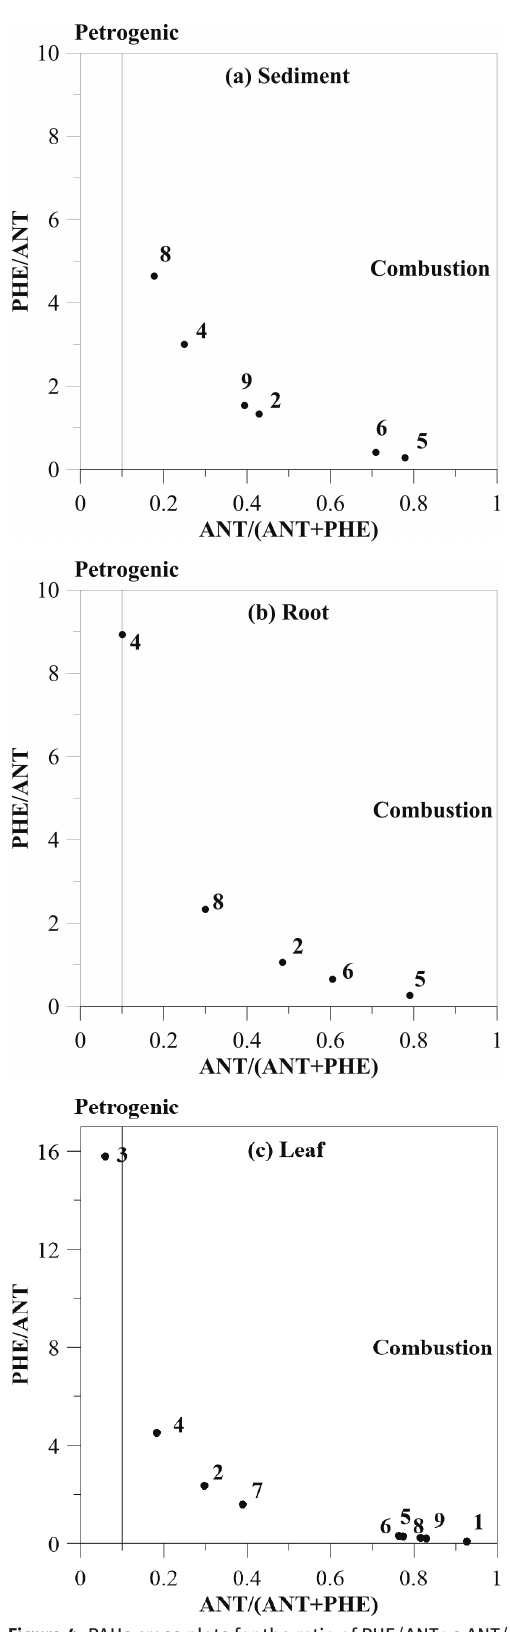
Figure 4: PAHs cross plots for the ratio of PHE/ANT vs ANT/ (ANT+PHE) for sediment, root, and leaf